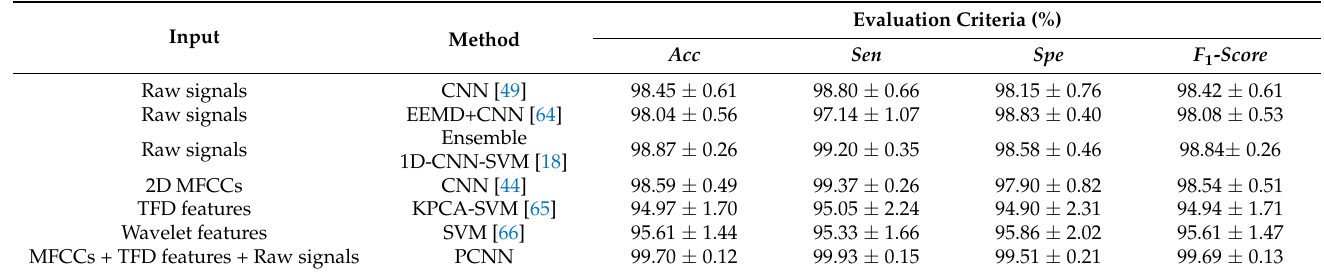
Table 7. Performance comparison among different leak detection frameworks.